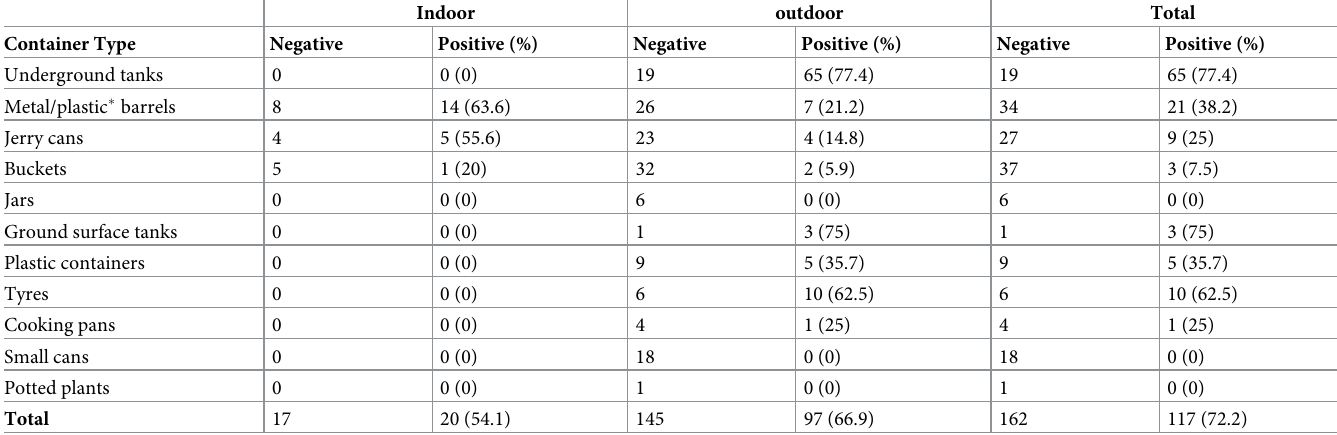
Table 1. The number of wet containers sampled indoors and outdoors and immature Ae . aegypti positivity